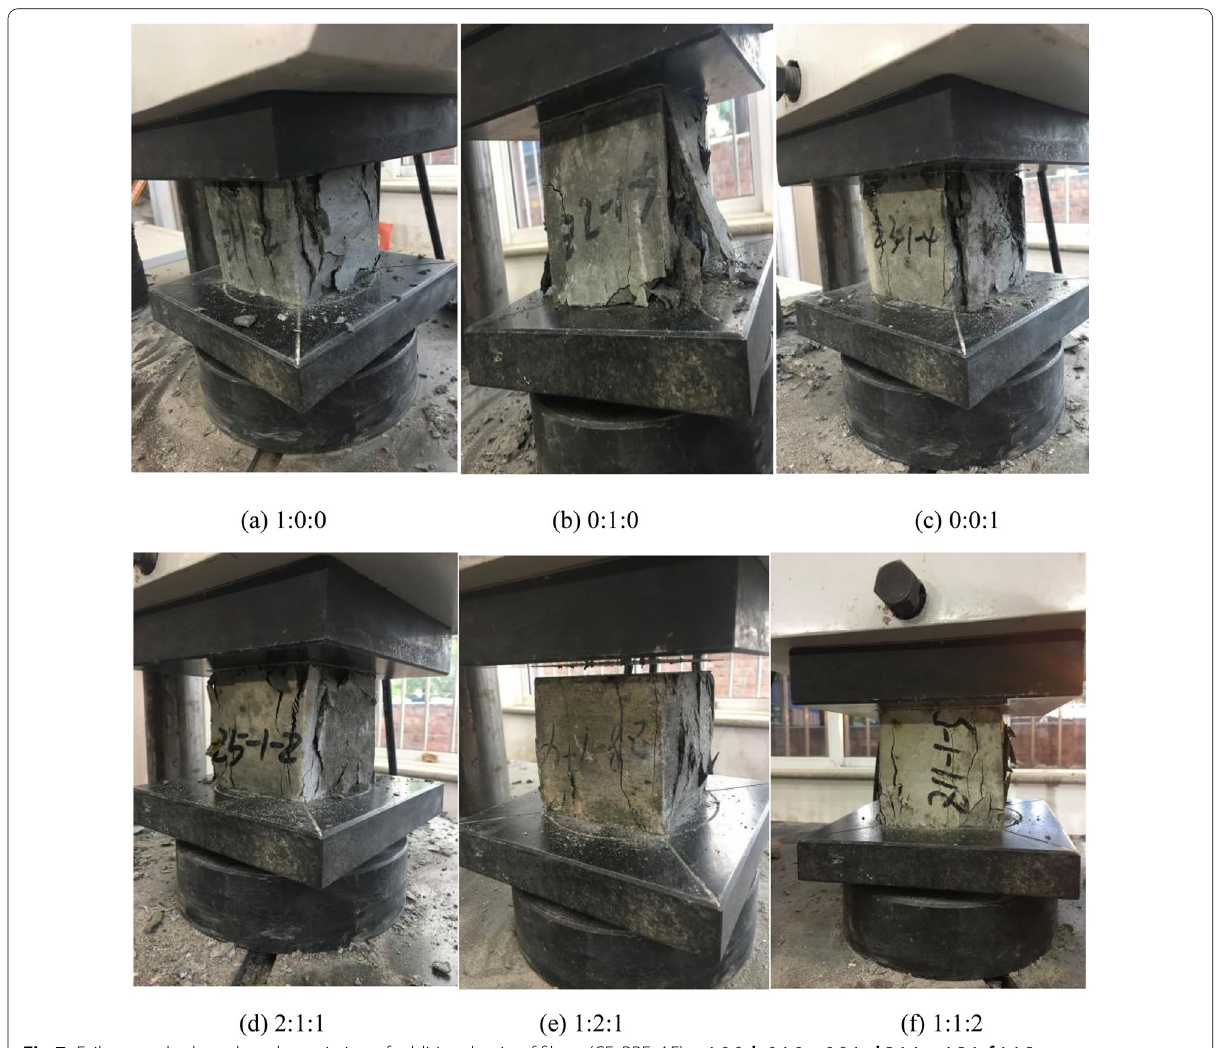
Fig.7 Failure modes based on the variation of additional ratio of fibers (CF: PPF: AF). a 1:0:0. b 0:1:0. c 0:0:1. d 2:1:1. e 1:2:1. f